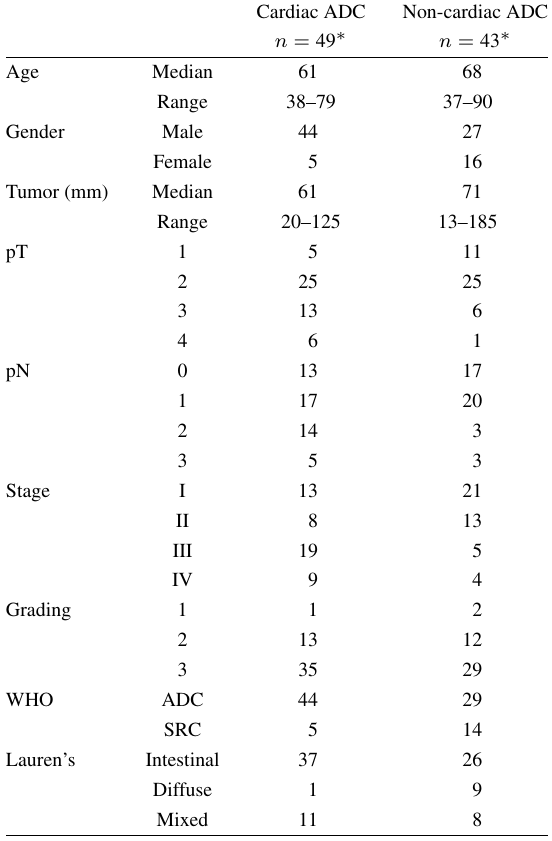
Characteristics of patients and